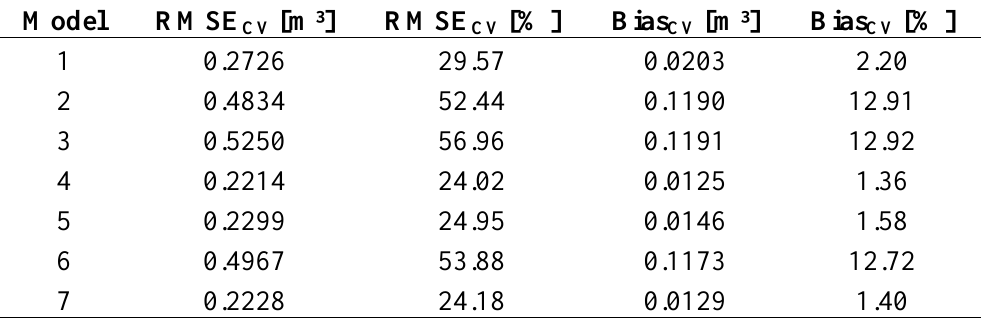
Table 10. Prediction accuracy of the different regression